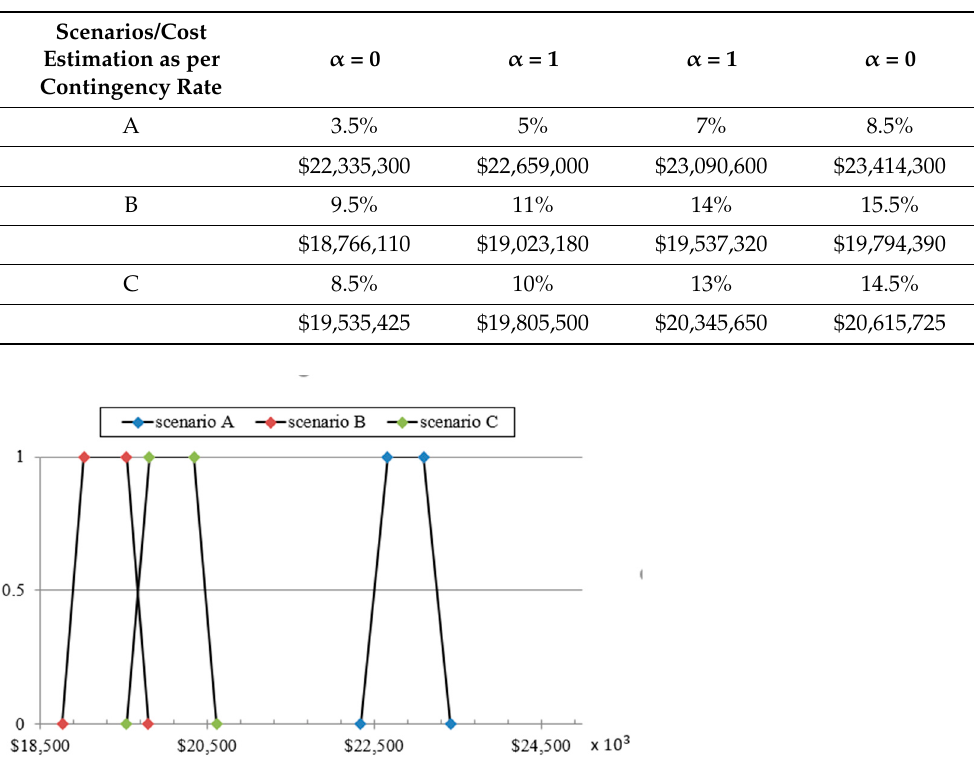
Figure 4. Independence case of difference of scenarios B and C. As presented in Figure 4, according to this perspective, it noted that the difference between scenarios b and c has a positive value at the right extreme when independent of each other. In this case, it implies that there is a possibility that scenario C will be better. However, if the two variables are dependent on each other, the right extreme value of the difference between the two scenarios appears as approximate 0. It implies that the value of scenario B has a lower cost than choosing scenario C in any case.